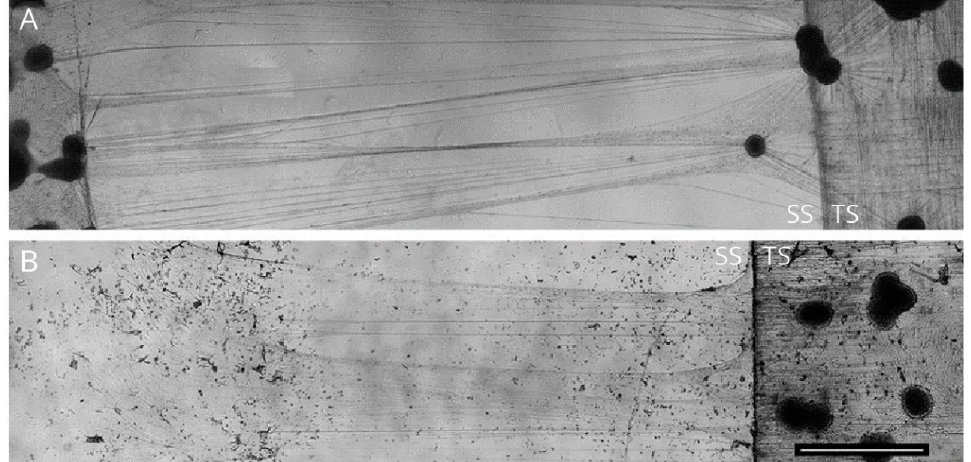
Figure 4. Axonal stretching from DRG explants. Image showing neurons from DRG explants cultured on a stationary substrate (SS) and a mobile towing substrate (TS). Neurons cultured on both SS and TS when exposed to controlled stretching force yielded axons with bi-directional polarity ( A ), while neurons cultured exclusively on TS yielded axons with unidirectional polarity ( B ). Scale bar = 2 mm (reproduced with permission from Bryan J. Pfister, Department of Biomedical Engineering, New Jersey Institute of Technology, Newark, NJ, USA. Journal of Neurotrauma, 28 (11), 2011, 2389–2403, Mary Ann Liebert, Inc.).